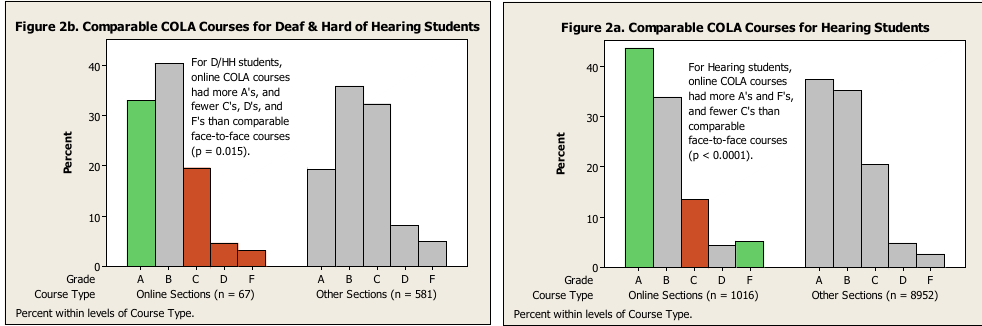
Figure 2b. Comparable COLA Courses for Deaf & Hard of Hearing Students